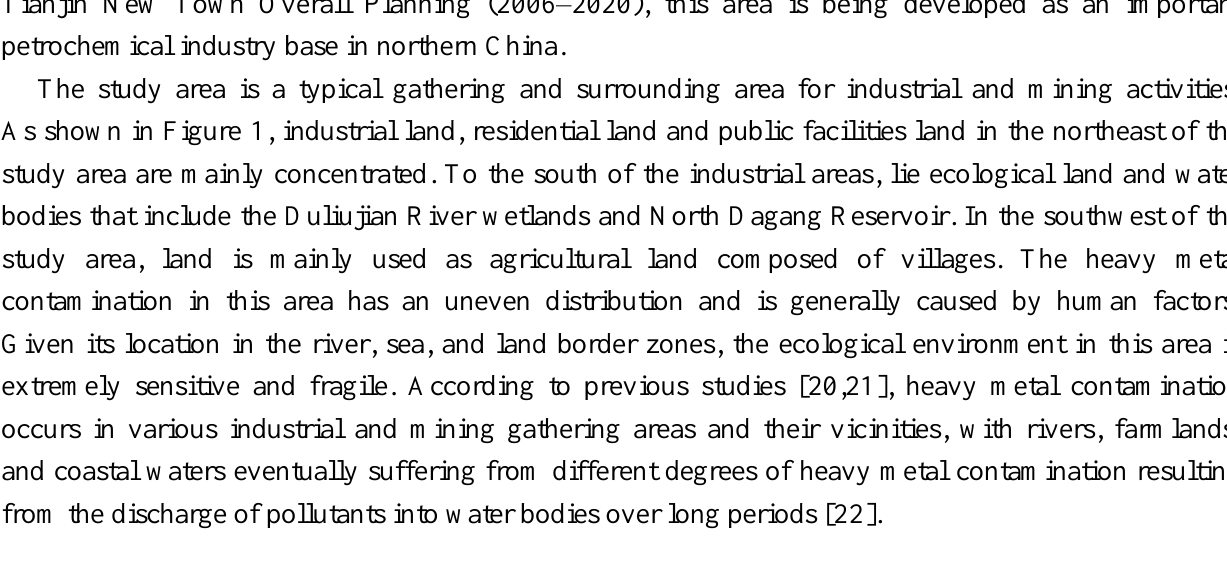
Figure 1. Landuse of study